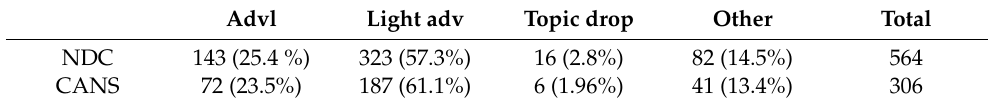
Table 2. Initial element in XVS-declaratives. Advl Light adv Topic drop Other Total NDC 143 (25.4 %) 323 (57.3%) 16 (2.8%) 82 (14.5%) 564 CANS 72 (23.5%) 187 (61.1%) 6 (1.96%) 41 (13.4%)